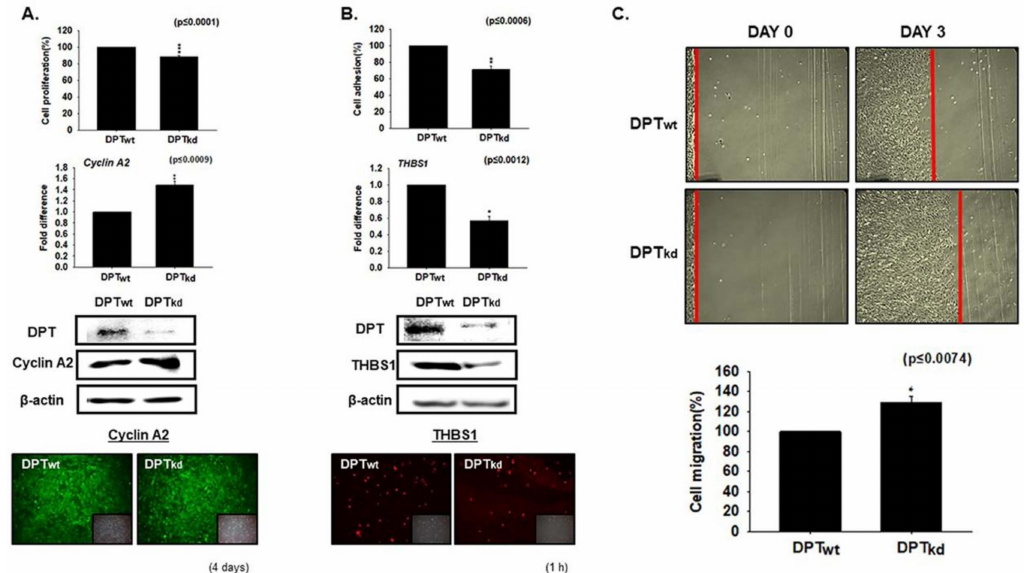
Figure 1. Adhesion and proliferation in dermatopontin (DPT) knockdown cells. ( A ) DPT knockdown (DPT kd )andnormalcellswereculturedinmediasupplementedwith10%FBSfor4days.